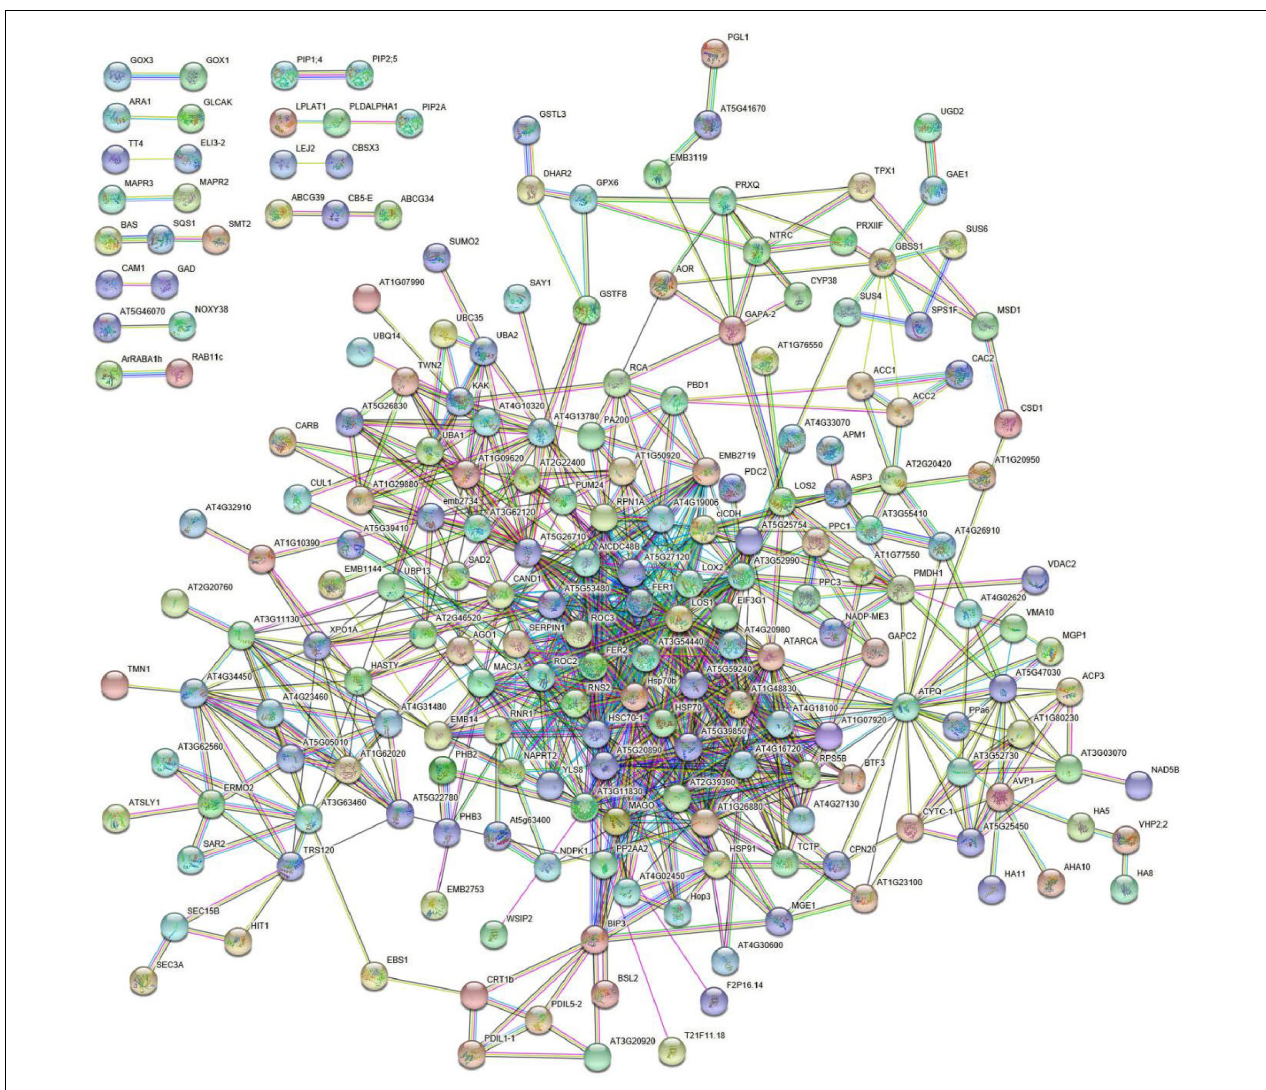
FIGURE 5 | STRING analysis of differentially represented proteins present in strawberry fruits produced by plants subjected to the treatments with Trichoderma strains (T22, TH1, and GV41), as compared to control (CTR). Functional protein associations were based on data recorded for A. thaliana protein homologs. Only high-confidence interactions (0.7) are shown. Protein codes are reported in Supplementary Table S5